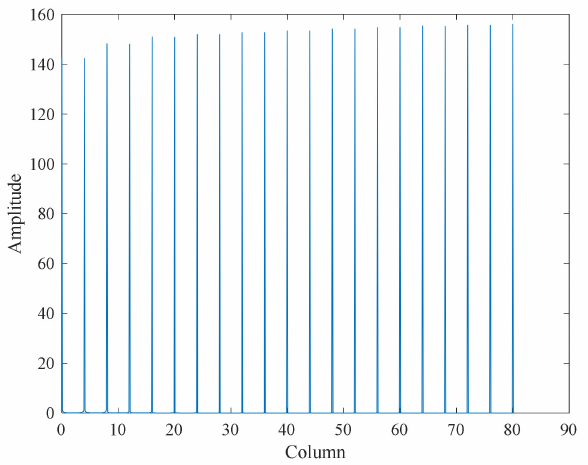
Figure 9. Fourier analysis diagram.